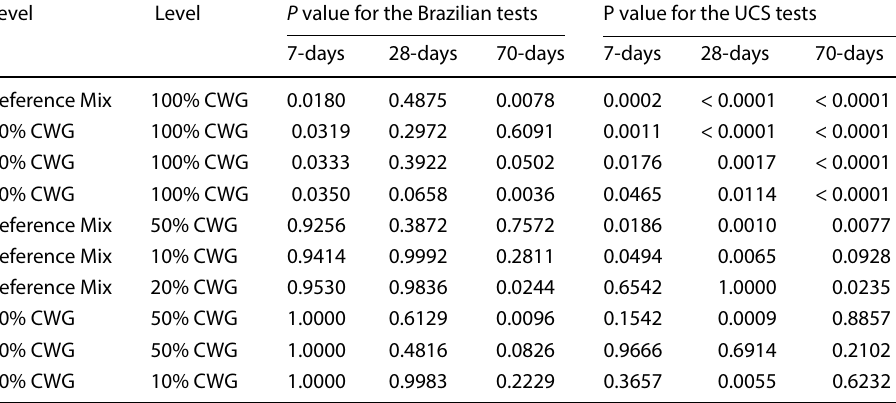
Table 8 Tukey comparisons for the UCS and Brazilian test